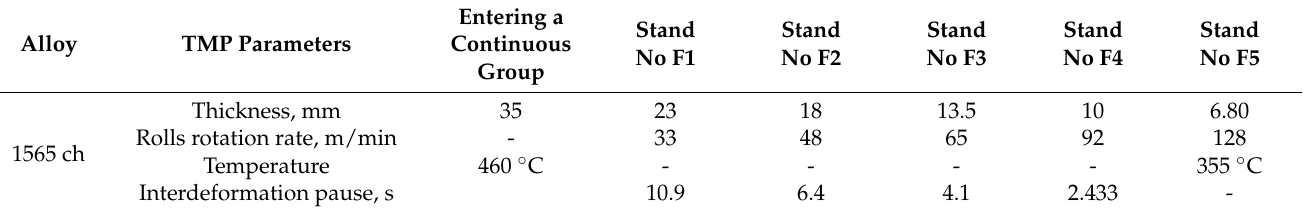
Table 3. Rolling of the AlMg 6 Mn 0.7 (1565 ch) alloy in the continuous group of the “Quarto 2800”